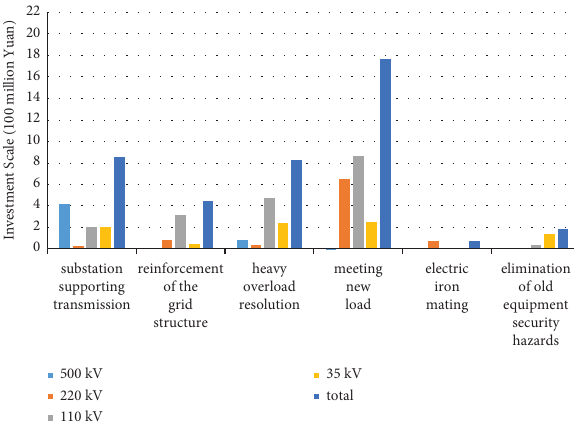
Figure 7: Optimal solution with a security beneft objective at 500 kV/220kV/110kV/35kV voltage